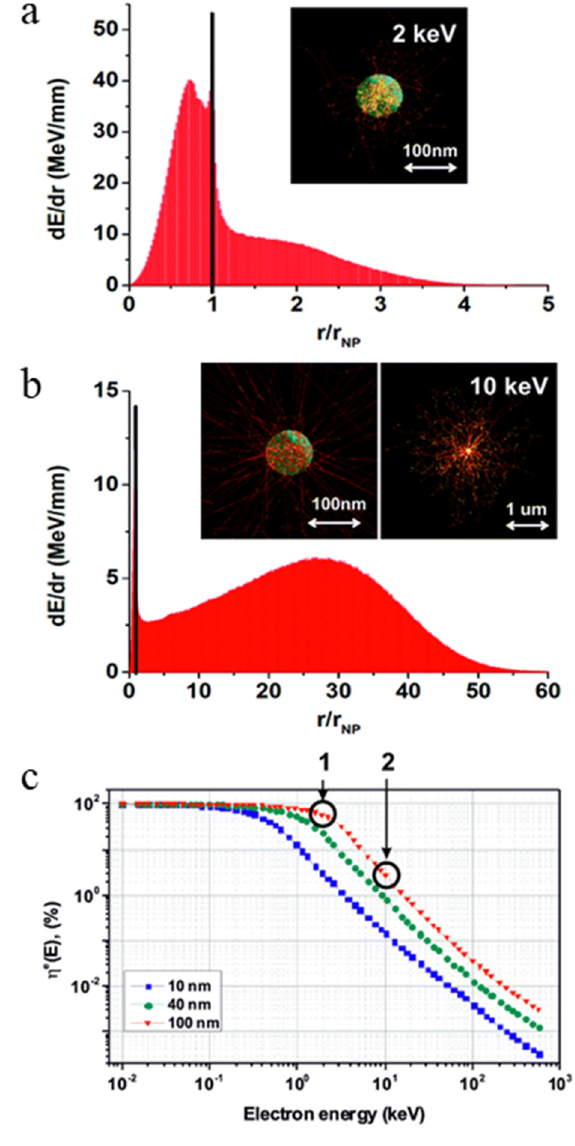
Figure 7. ( a , b ) Deposited energy per unit of normalized radial distance from the center of the NP (diameter of 100 nm of Gd 2 O 3 ) for (1)—2 keV electrons and (2)—10 keV electrons. Visualization of the spatial distribution of the deposited energy is shown as insets. ( c ) Percentage of deposited energy per electron generated in a Gd 2 O 3 nanoparticle for three different diameters, as a function of the primary electron energy. Reproduced from Nanoscale 2015 , 7 , 5744–5751 [162] . Copyright Royal Society of Chemistry 2015.